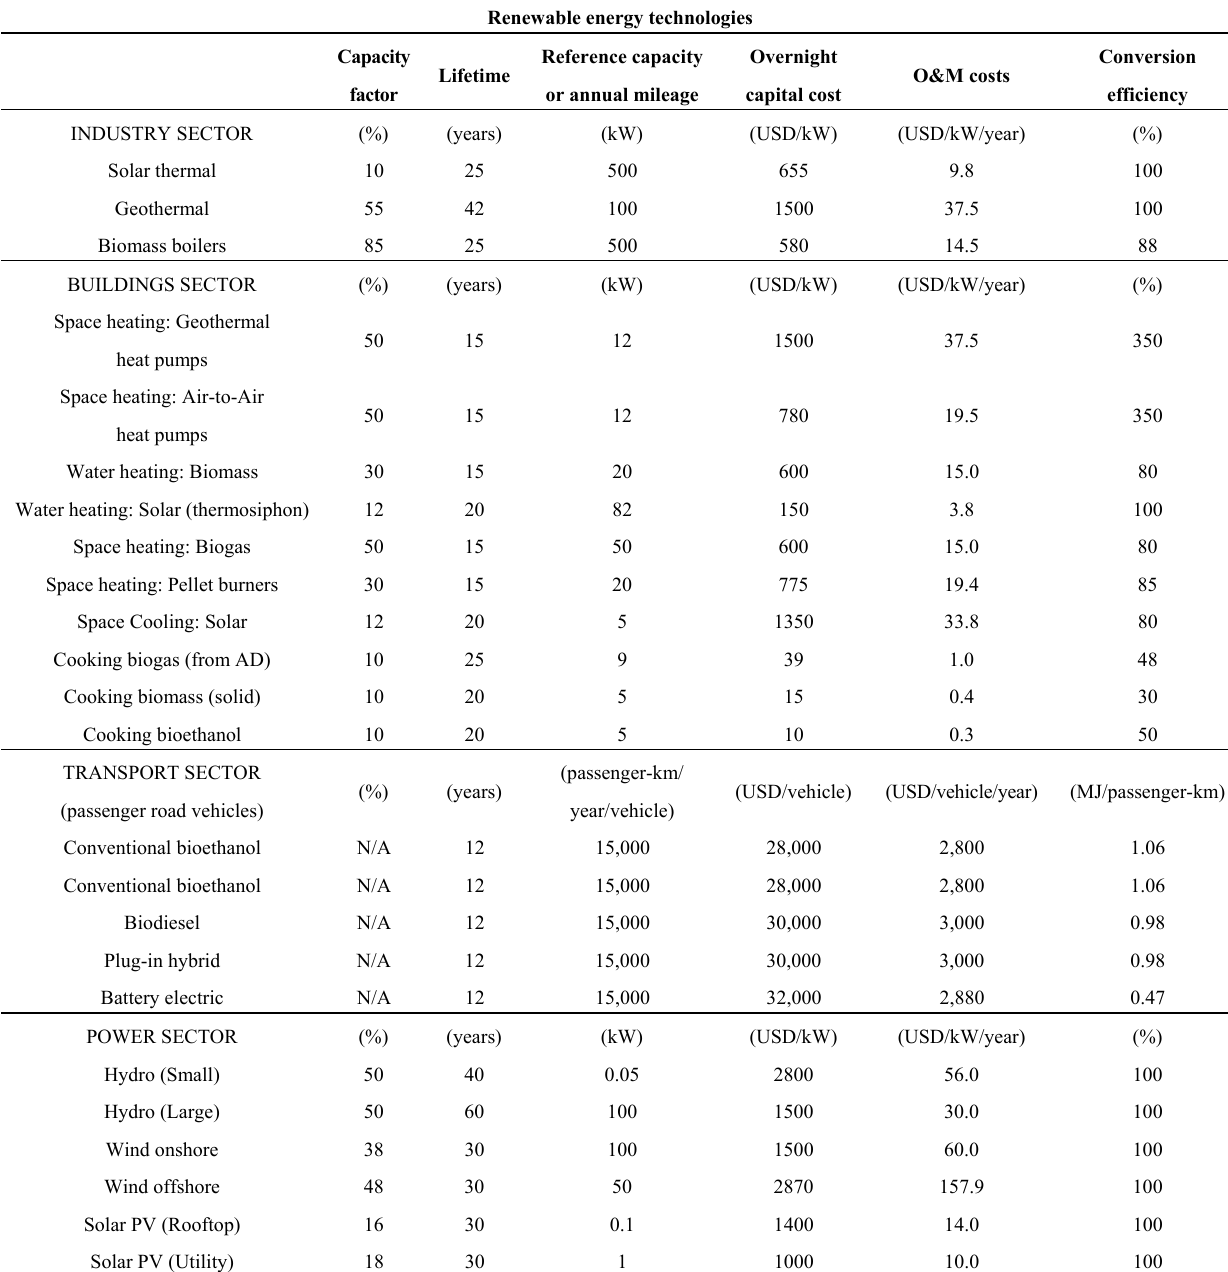
Table A3. Assumed international technology cost and performance data in